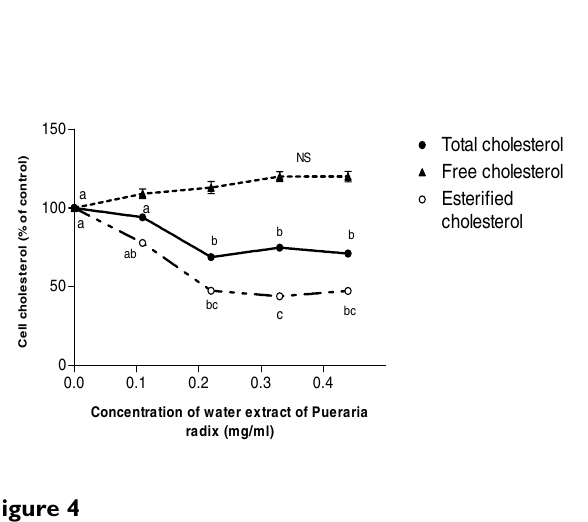
The effect of water extract of Puerariae radix on intracellular total cholesterol, free cholesterol and esterified cholesterol concentrations. CaCo2 cells were incubated with water extract of Puerariae radix for 24 h. Total, free and esterified cholesterol levels in the cells are expressed as a percentage of control ± SEM (n = 3). Means were compared using one-way analysis of variance (ANOVA) followed by Tukey's post-hoc test. Different letters in graphs indicate significance at p < 0.05. NS: not significant at p >